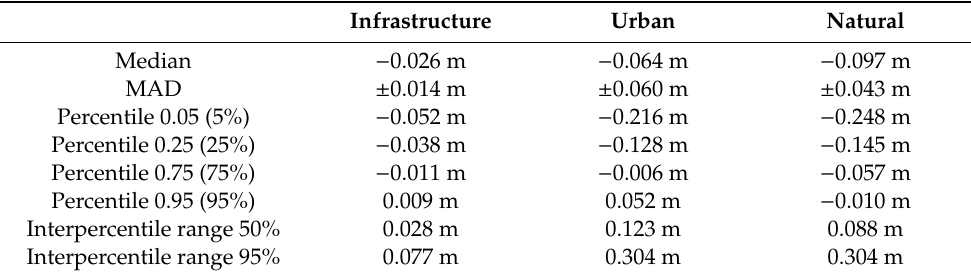
Table 5. Robust assessment for each study case.